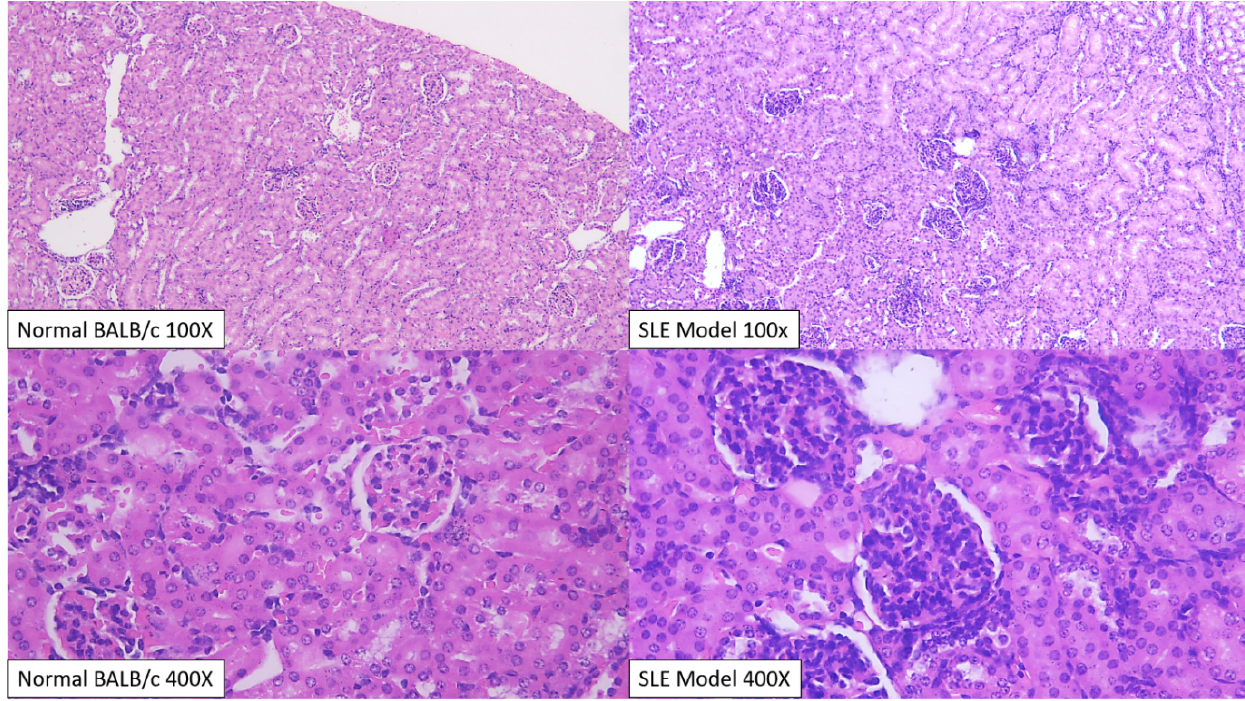
Figure 3. Kidney of BALB/c mice stained with hematoxylin and eosin, before intervention. Analysis on normal BALB/c control kidney (upper and lower left) revealed mild tubulo-nephritis changes, with minimal mesangial expansion, endocapillary proliferation and capillaritis. Significant interstitial infiltration (25–50% field) only happens in one member of normal BALB/c group. In the SLE model group (upper and lower right), after induction with pristane, there was a significant change in the glomeruli, with dominant endocapillary proliferation and minimal mesangial expansion and